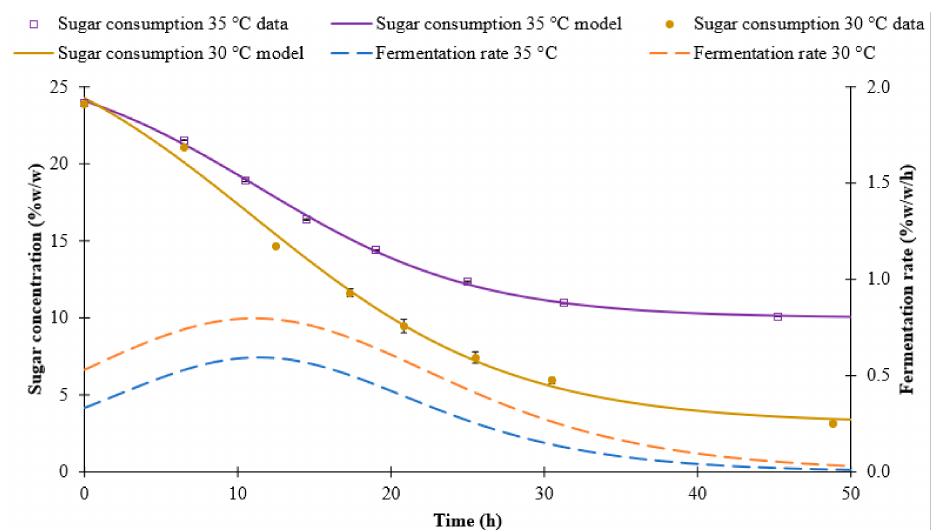
Figure 3. Sugar concentration and fermentation rate calculated by taking the 1st derivative of the sugar consumption model (Equation (2) and Equation (1), respectively). Data shown represent fermentation data at 30 ◦ C (brown circles) and 35 ◦ C (purple squares); sugar consumption model at 30 ◦ C (purple line) and 35 ◦ C (brown line); and fermentation rate model at 30 ◦ C (orange dashed line) and 35 ◦ C (blue dashed line). Fermentations were performed in duplicate. The error bars represent the standard deviation of the